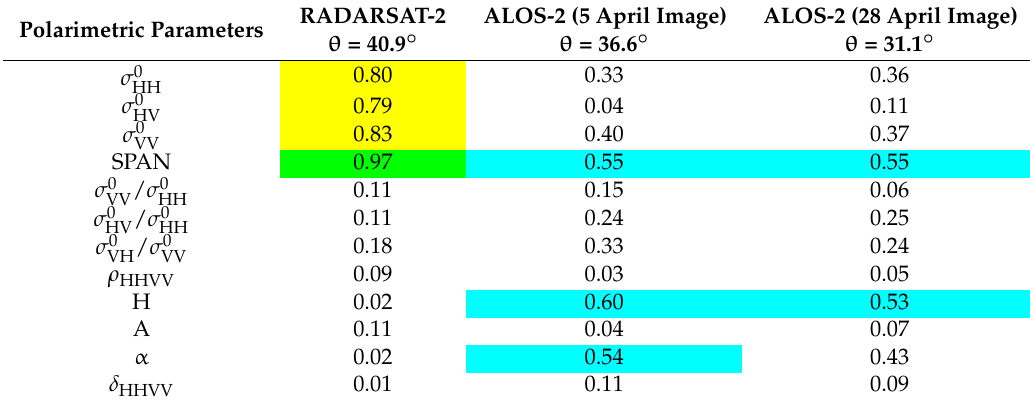
Table 3. K-S distance between FYI and OI. Green cells refer to parameters with very good separability, yellow cells refer to parameters with good separability, and cyan cells refer to parameters with some separability.